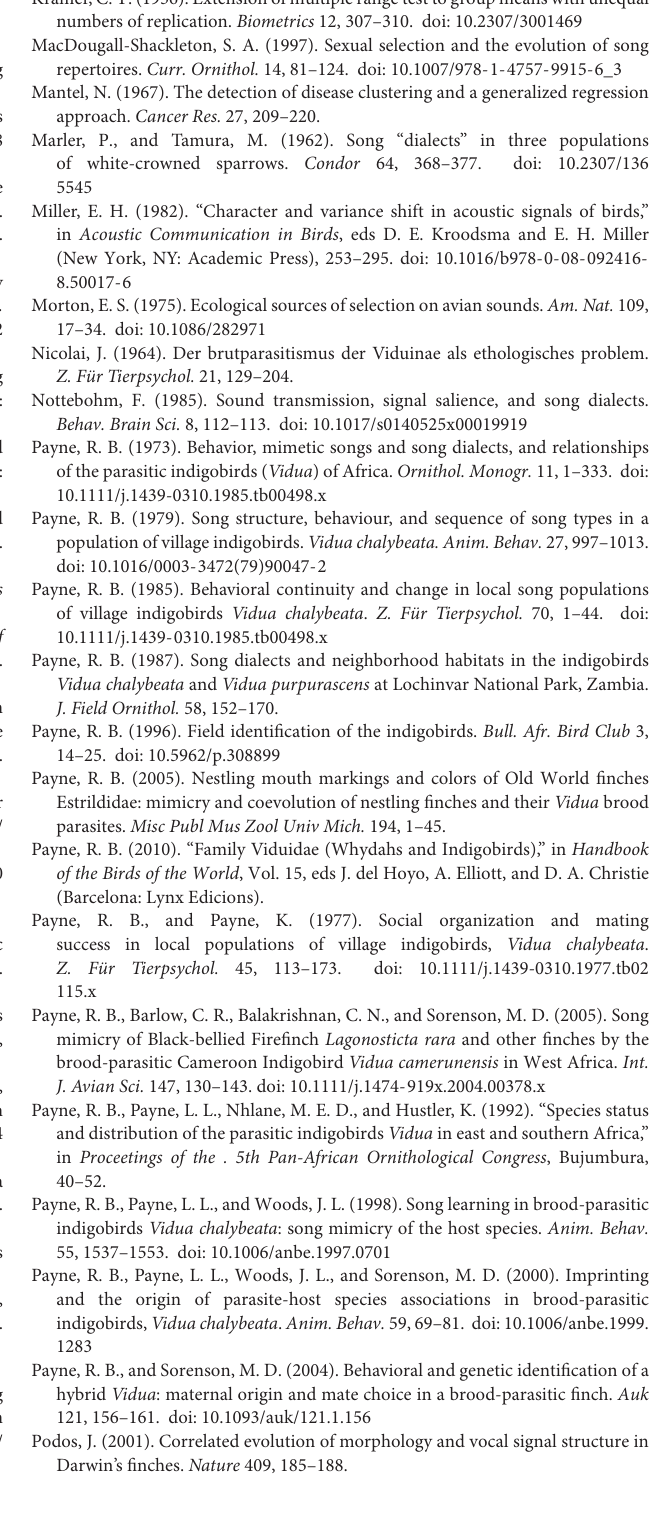
Supplementary File 2 | DaCostaSorenson_song_sharing.xlsx. Jaccard index calculations of non-mimicry song sharing among conspecific indigobirds, with a separate worksheet for each region.